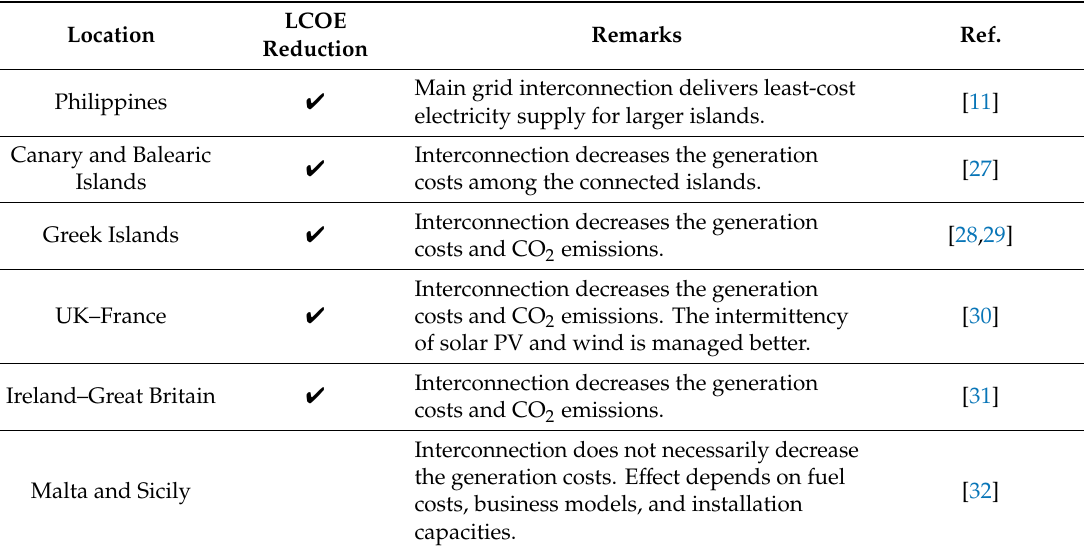
Table 3. Summary of studies about clustered